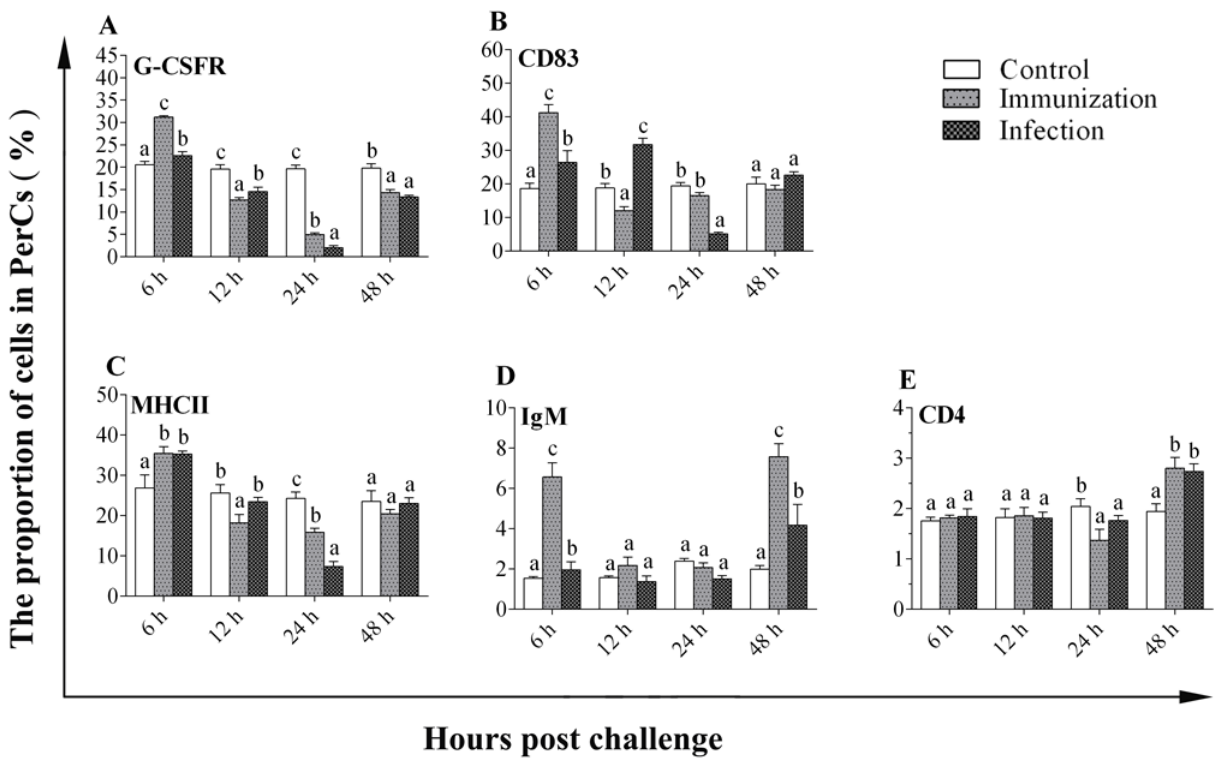
Figure 5. Proportions of different cells in the peritoneal cavity included G-CSFR + ( A ), CD83 + ( B ), MHC Ⅱ + ( C ), IgM + ( D ), and CD4 + ( E ) cells. Results are expressed as means ± SD of three replicates. Different letters on the bars denote the statistical significance ( p < 0.05).